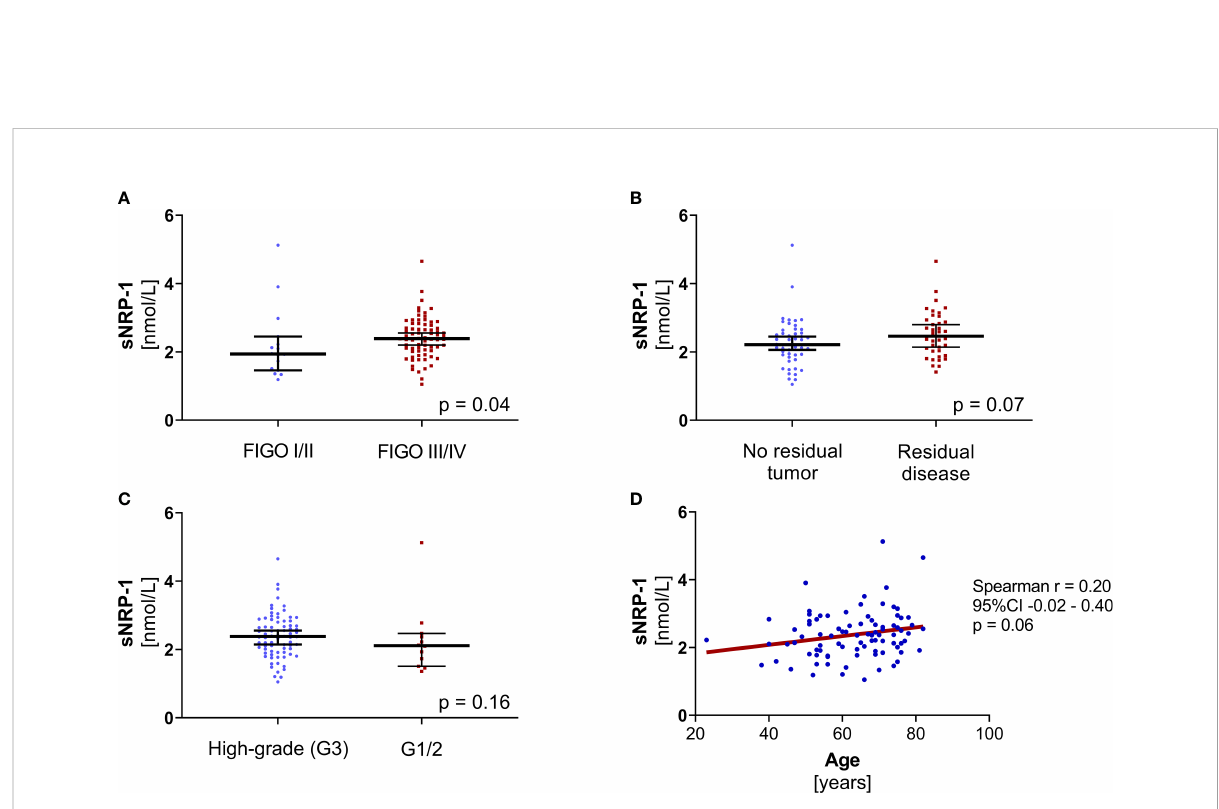
FIGURE 2 Association analyses of sNRP-1 with known clinical parameters. (A) The sNRP-1 levels of patients with advanced ovarian cancer (FIGO III/IV, n = 72) compared to patients with early-stage disease (FIGO I/II, n = 16), p = 0.04. (B) The sNRP-1 levels of patients (n = 39) with residual tumor compared to patients (n = 49) with no macroscopic tumor after cytoreductive surgery, p = 0.07. (C) The sNRP-1 levels of patients (n = 76) with high-grade ovarian cancer compared to patients (n = 12) with lower grading, p = 0.16. The black horizontal lines indicate the median sNRP-1 levels in each group with error bars, showing the 95%CI. P-values according to the non-parametric, two ‐ sided Mann-Whitney test. (D) The correlation of sNRP-1 and age is shown, using non-parametric Spearman correlation (n = 88, p = 0.06) with simple linear regression (red